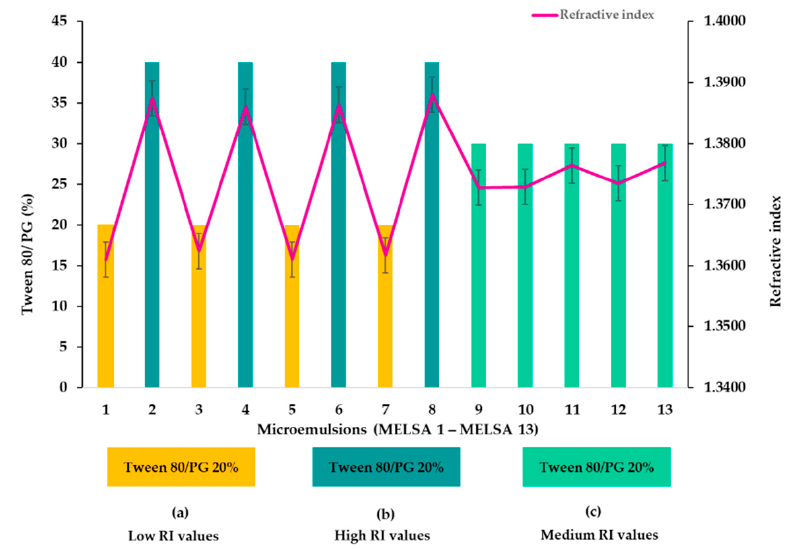
Figure 4. Graphical representation of refractive index variation for microemulsions, considering three cases: ( a ) systems with low RI values, ( b ) systems with high RI values, and ( c ) systems with medium RI values, depending on Tween 80/PG concentration.